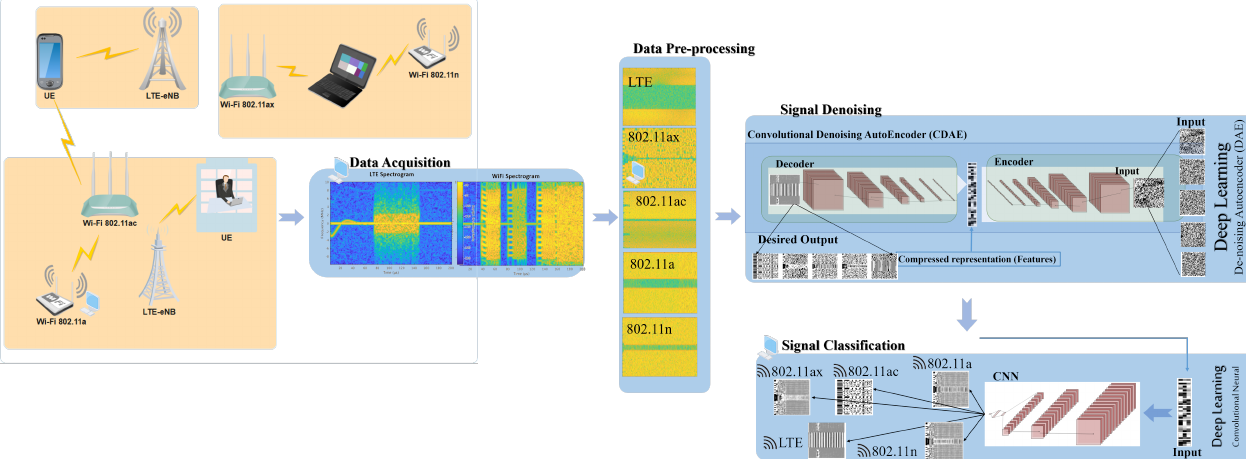
Figure 3. Proposed system for unlicensed protocol identification under noise and different channel propagation